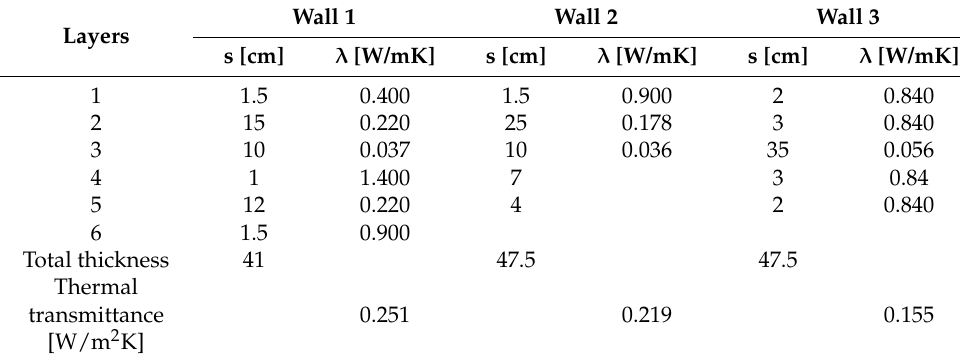
Table 4. Thermal properties of defined